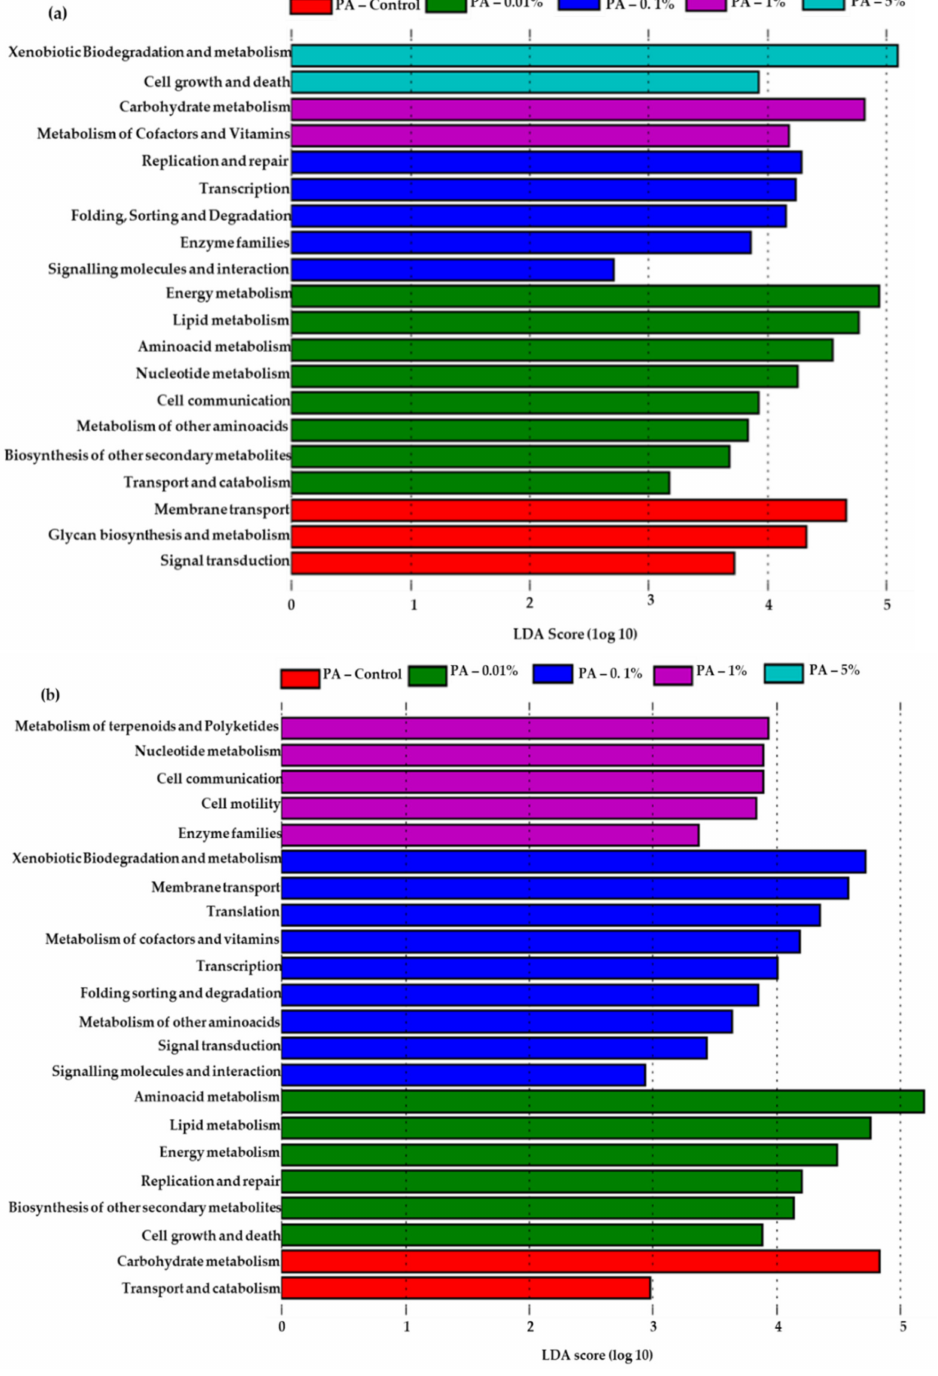
Figure 4. Prediction of the predominant functional potential of bacterial communities using LEfSe analysis for soil A ( a ) and soil B ( b